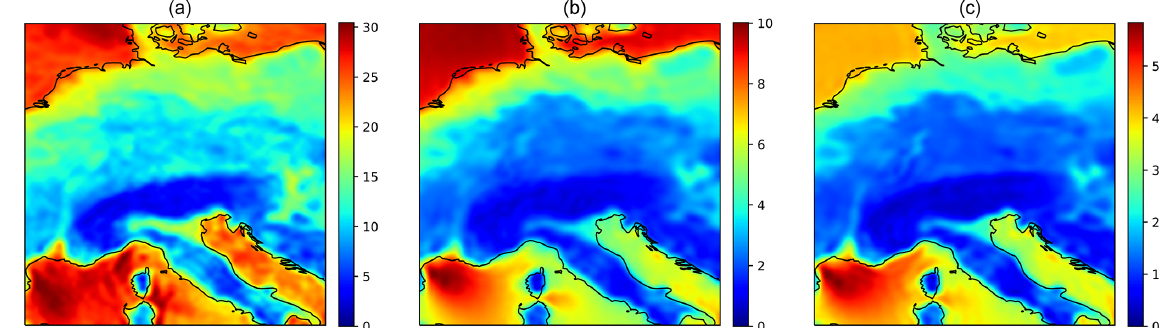
Figure 2. Colour maps of the maximum (a) , mean (b) and standard deviation (c) of the wind speeds (in ms − 1 ) over the region. The figures display a sharp division of the statistics along the